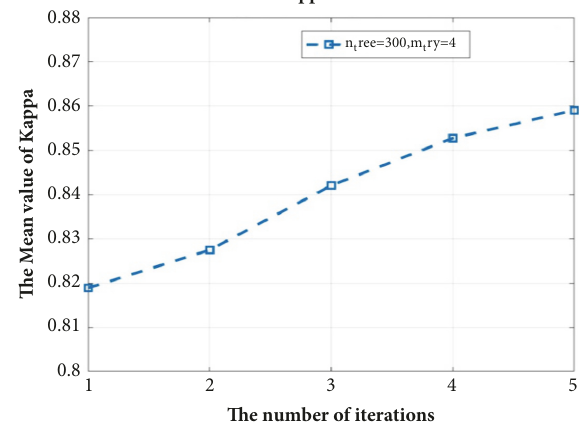
Figure 25: Classification accuracy trend of different initial and iterative condition of AVIRIS data for method 1.